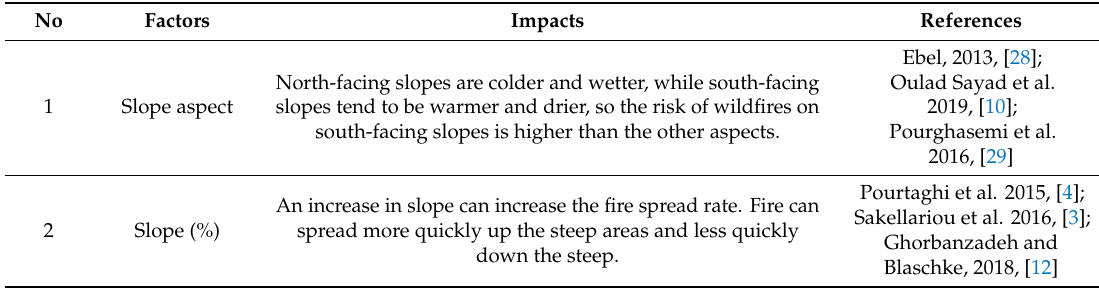
Table 6. A summary of the literature review of the importance of wildfire conditioning